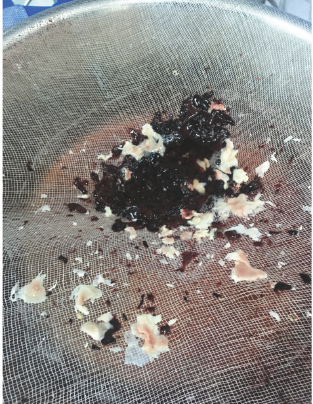
Figure 5: Clots and sloughed necrotic tissues evacuated from the